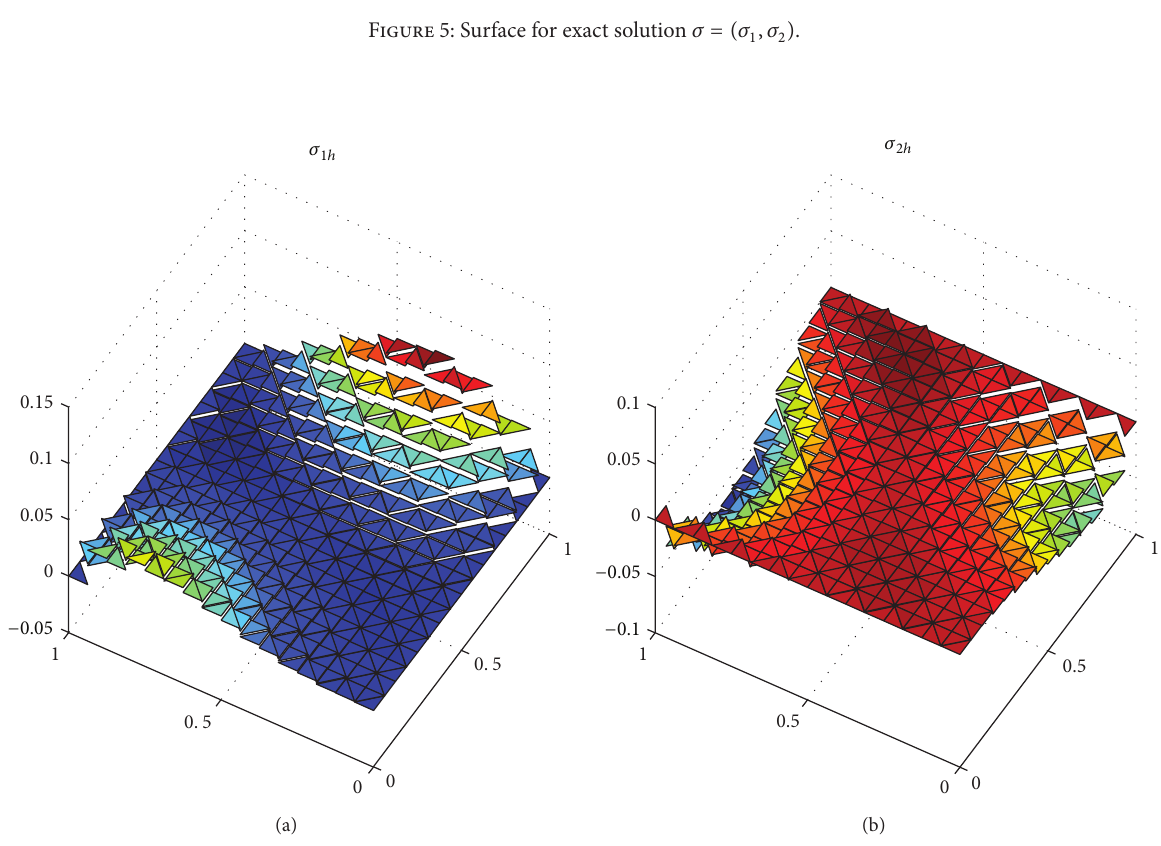
Figure 6: Surface for numerical solution 𝜎 ℎ = (𝜎 1ℎ ,𝜎 2ℎ )